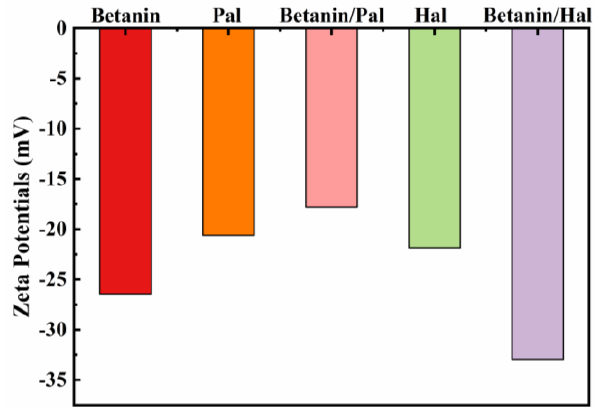
Figure 2. Zeta potentials of betanin, clay minerals and hybrid materials.